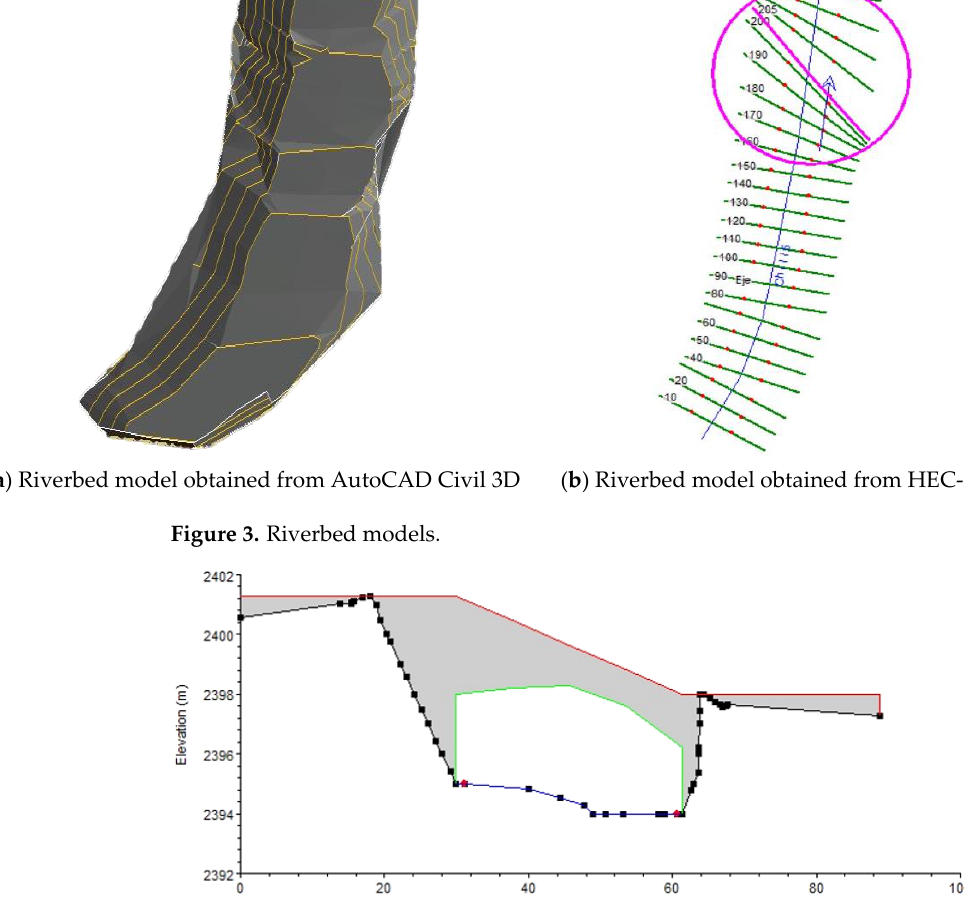
Figure 4. Cross section of the bridge.